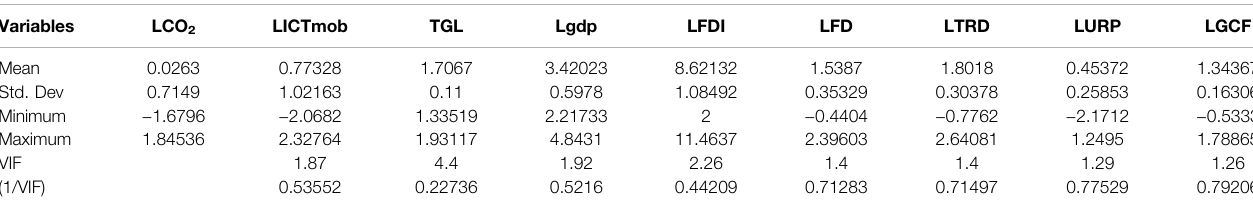
TABLE 3 | Descriptive